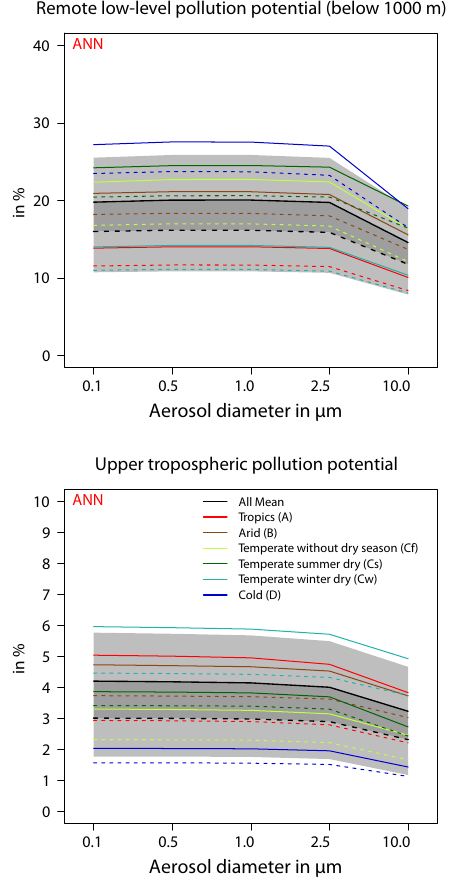
Fig. 2. Annual averages of RCL 0.5km (upper panel), ELR 1km (mid- dle panel), and E UT (bottom panel). Dark gray shaded areas repre- sent the area between the total means (black lines) of NS act (dashed) and NS inact (solid) MPC tracers. Light gray shaded areas show one standard deviation, plotted single sided for NS act and NS inact mean values. Colored lines represent the mean values for different climate classes: tropical (red, A); arid (brown, B); temperate, no dry season (light green, Cf); temperate, dry summer (dark green, Cs); temper- ate, dry winter (light blue, Cw); and cold (blue,